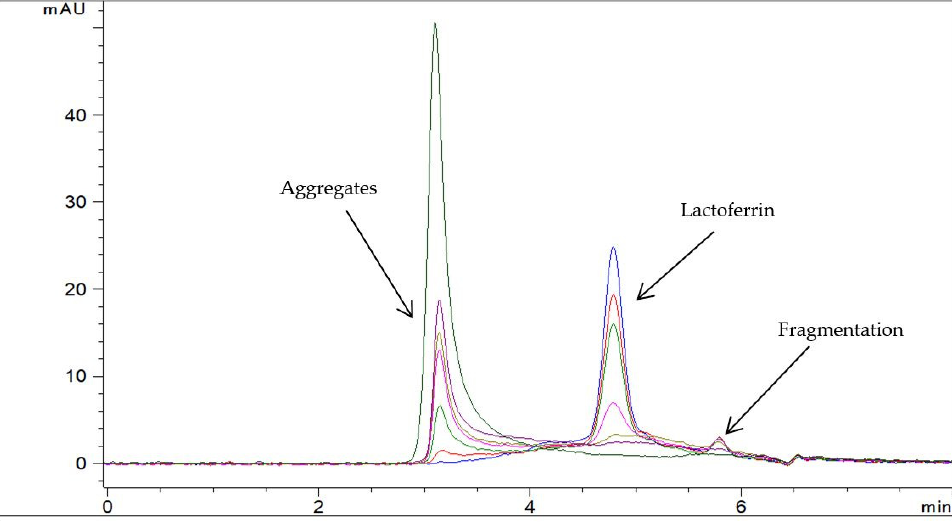
Figure 3. Representative chromatograms of Jarrow Formulas capsules with Lf in Milli-Q water (c = 1.0 mg/mL) at 60 °C at different time points: −− t = 0 min, −− t = 15 min, −− t = 30 min, −− t = 60 min, −− t = 120 min, −− t = 240 min, and −− t = 24 h (SEC-HPLC method).